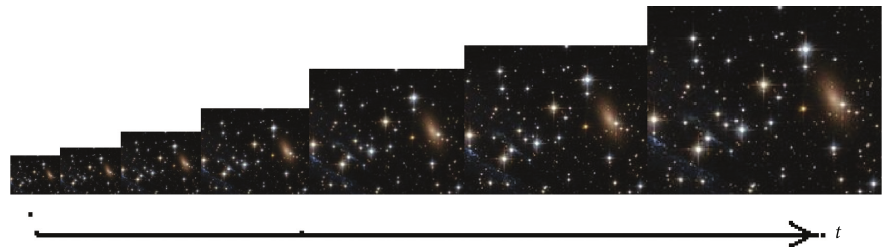
Figure 4: Schematic diagram of the generation process of cosmic